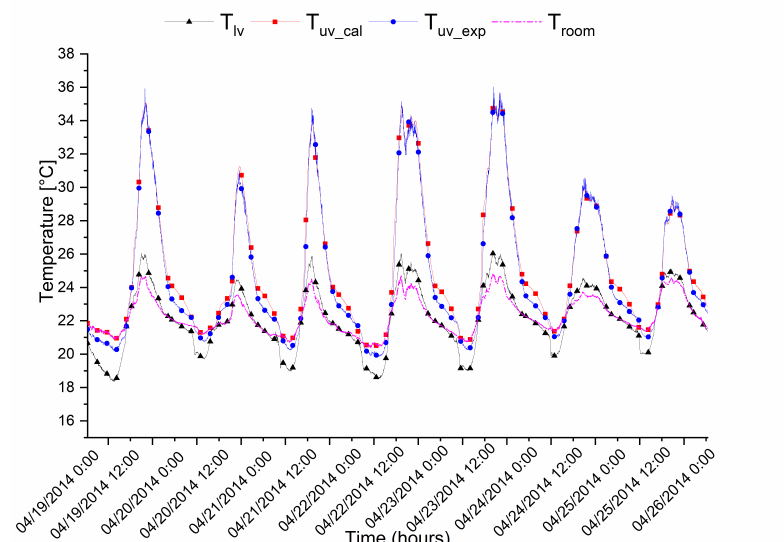
Figure 12. Comparison of air temperatures at the upper vent of the ventilated air layer (model results and experimentation). T lv is the experimental air temperature at the lower vent of the ventilated air layer; T uv_cal and T uv_exp denote respectively the evolution in numerical and experimental air temperatures at the upper vent of the ventilated air layer; T room is the room-temperature fluctuation.